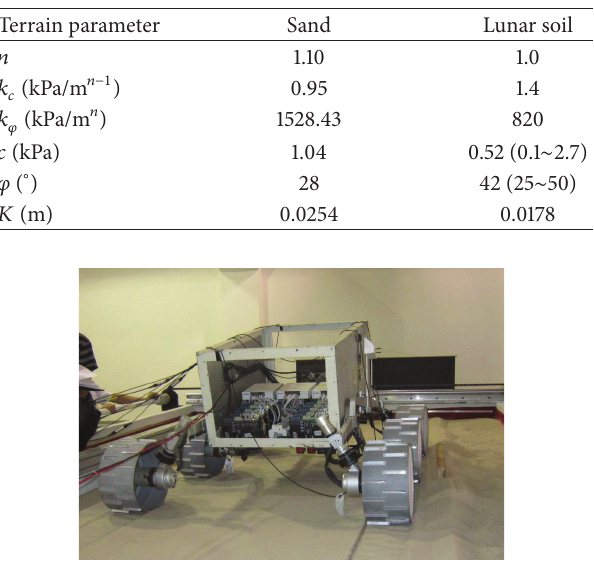
Table 1: Geometrical parameters of wheels. Table 2: Parameters of terrain mechanics of sand and lunar soil [14].